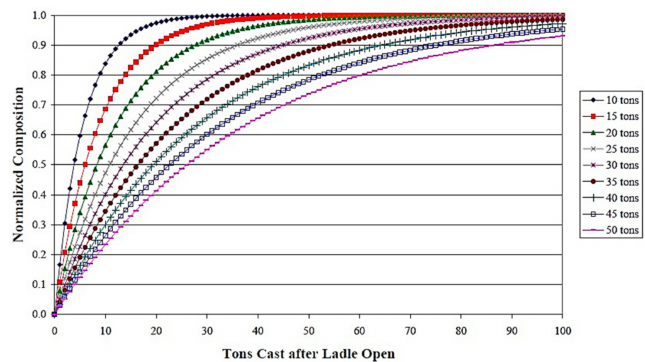
Figure 1. Basic nature of the influence of tested ultra-low tundish (ULT) practice on the Intermix (numerical